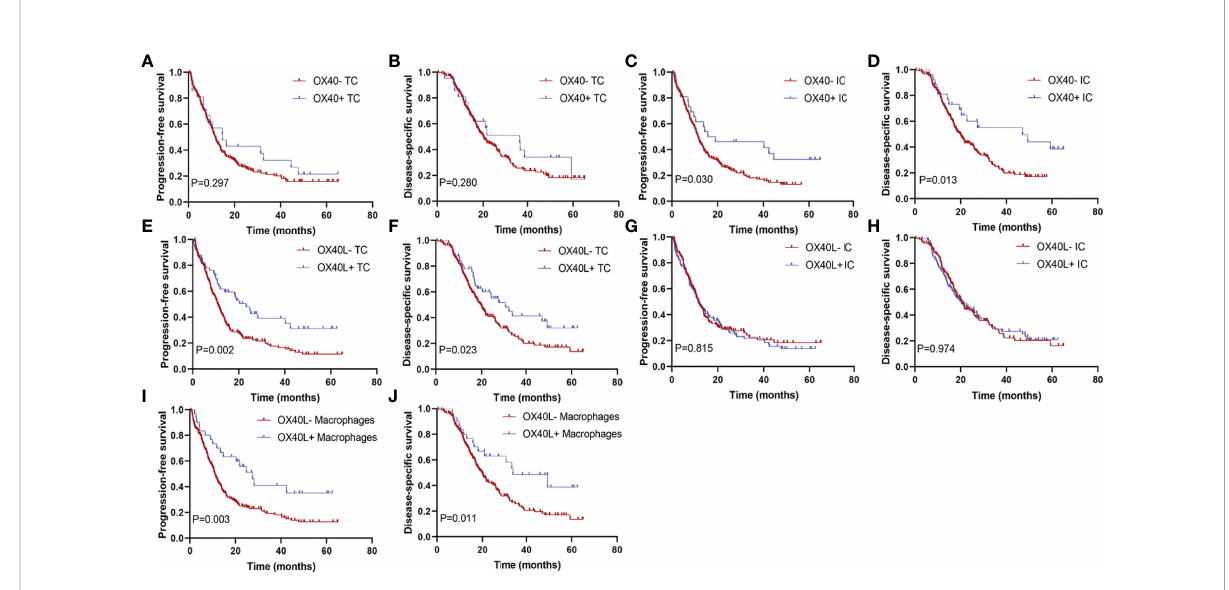
FIGURE 3 Kaplan – Meier curves according to OX40 and OX40L expressions. Progression-free survival for (A) OX40 expression on tumor cells (TCs), (C) OX40 expression on immune cells (ICs), (E) OX40L expression on TCs, (G) OX40L expression on ICs, and (I) OX40L expression on macrophages; disease-speci fi c survival for (B) OX40 expression on TCs, (D) OX40 expression on ICs, (F) OX40L expression on TCs, (H) OX40L expression on ICs, and (J) OX40L expression on macrophages.